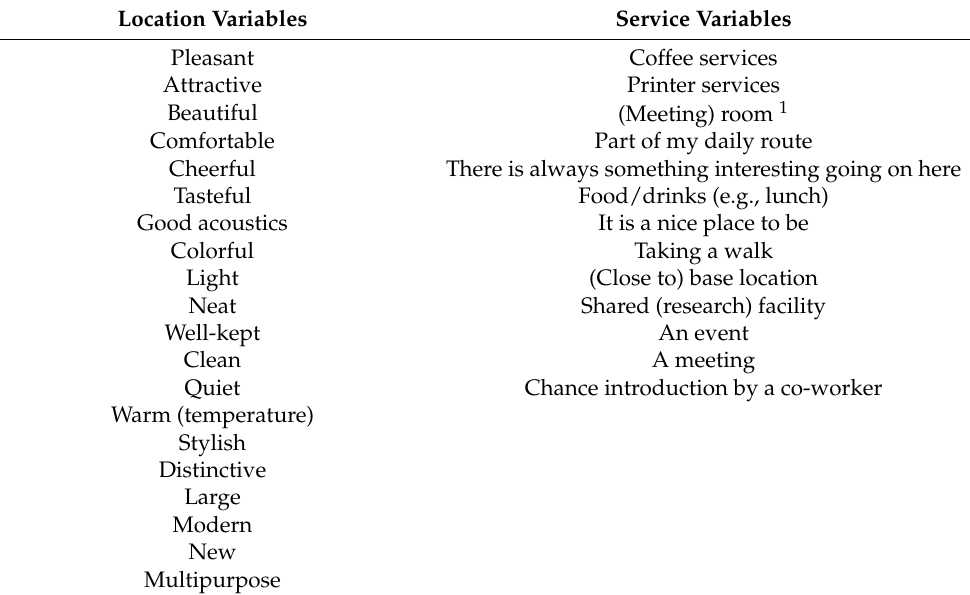
Table 2. Location and service